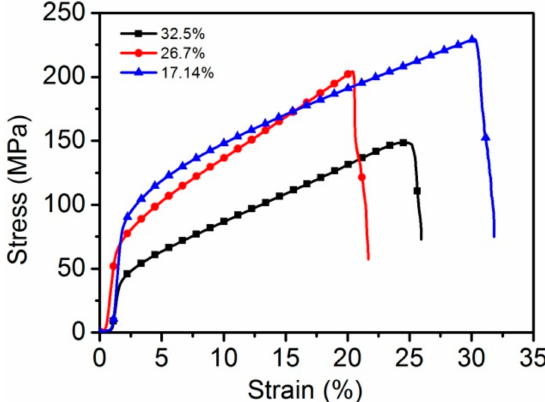
Figure 9. The uniaxial tensile stress-strain curves for the sintered wire mesh porous plates with different porosities.